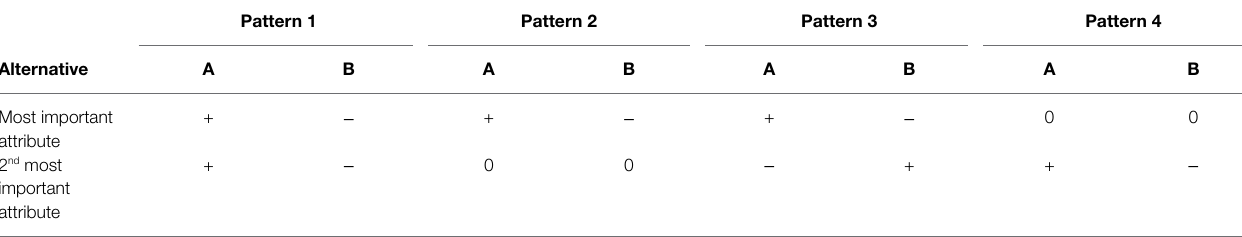
TABLE 4 | Attribute patterns used in Experiment